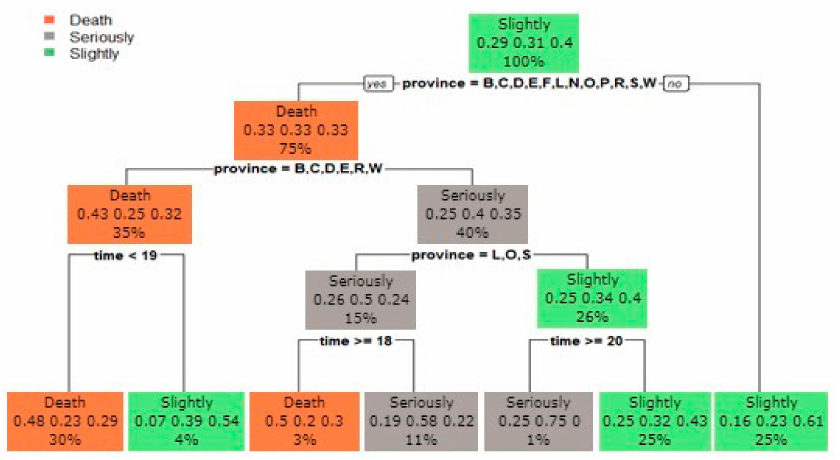
Figure 2. Classification tree for the variables of place and time of the accident.